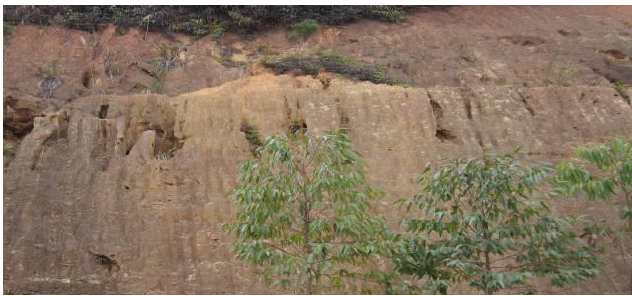
Figure 9. Weathering and surface erosion in a red-bed rock slope in South China.